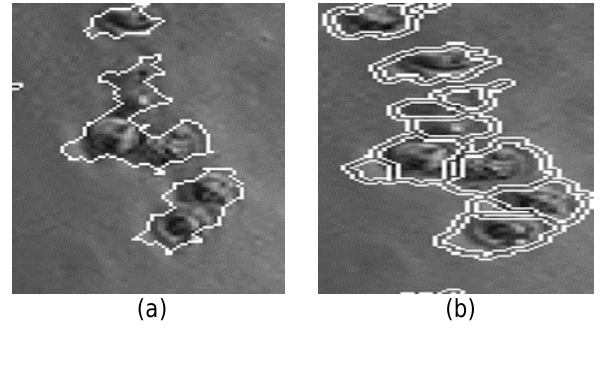
Figure 9 : (a) Clustered cells (b) Cells after